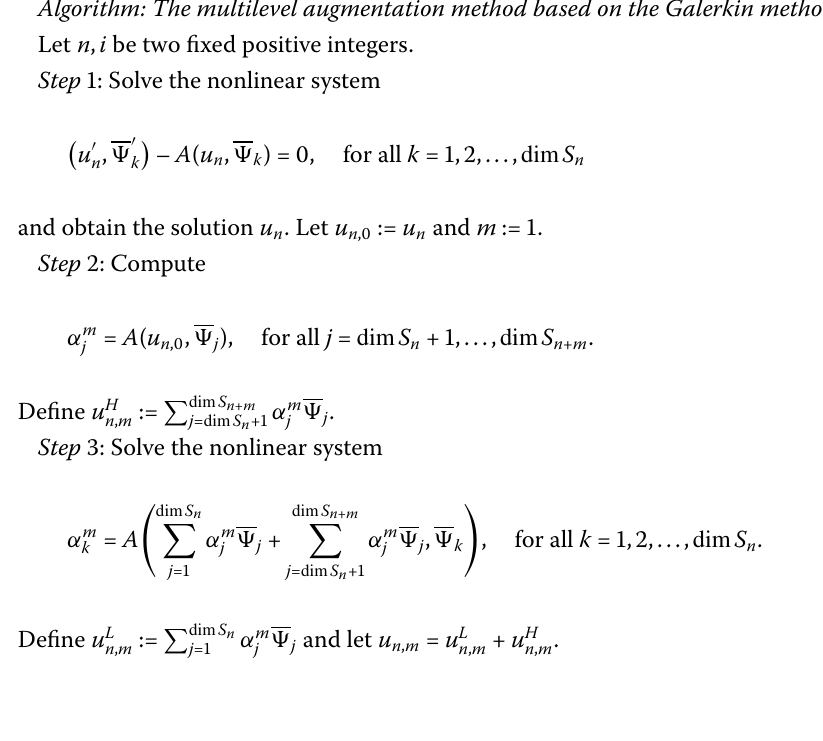
Algorithm: The multilevel augmentation method based on the Galerkin method . Let n , i be two fixed positive